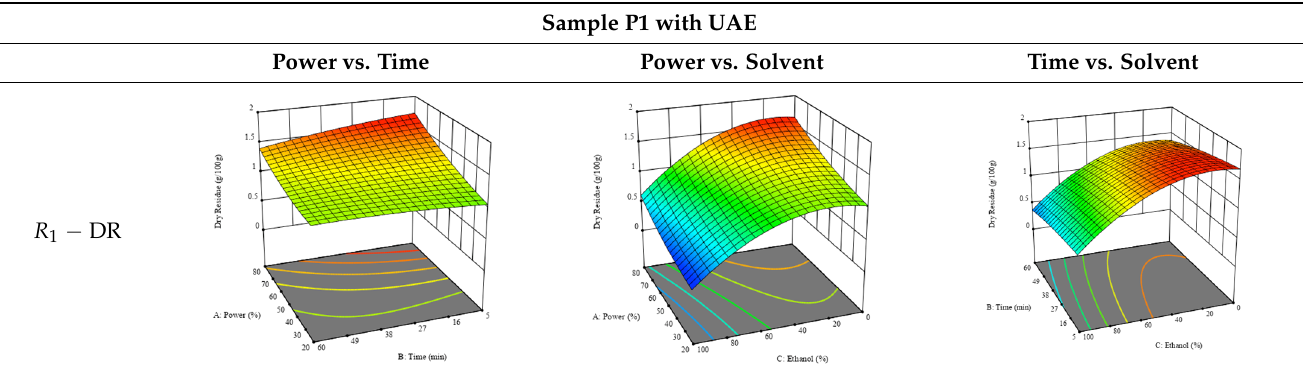
Table 6. 3D response charts of the ultrasound-assisted extraction (UAE) of ‘TL’ peel (P1) at the optimal values.